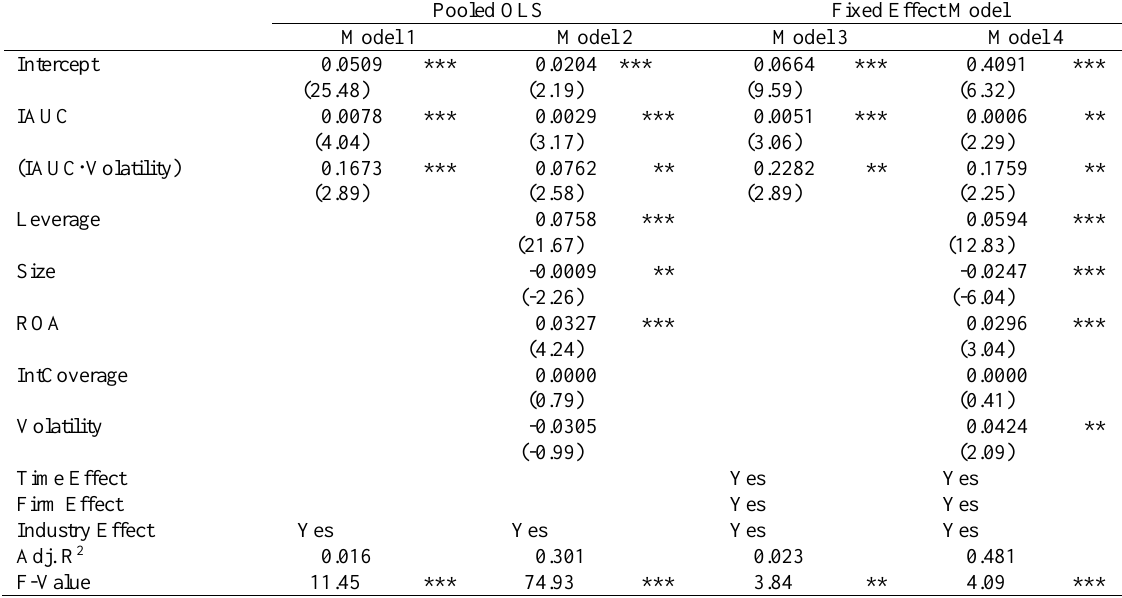
Table 11: Test results on hypothesis 2 for debt cost by using